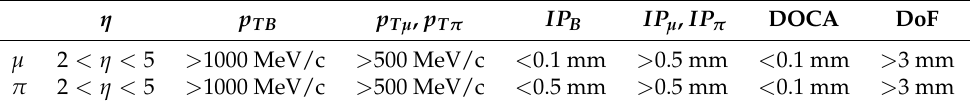
Table 1. Values for the cuts used in Pythia to generate the signal and background samples for the analysis. The meaning of these variables can be found in Table 2 and Figure 4, as well as in the main text.